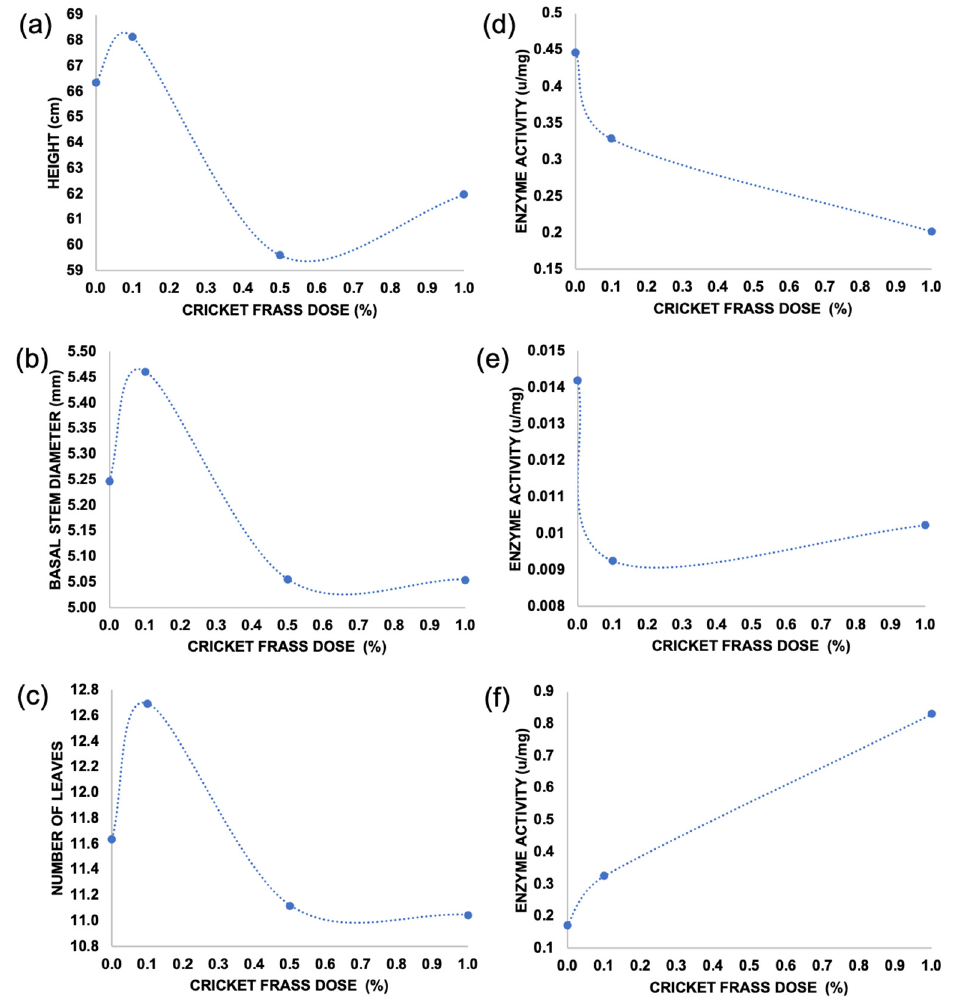
Figure 3. Dispersion diagram of morphological variables ( a ) height, ( b ) basal stem diameter, and ( c ) the number of leaves; and biochemical enzyme activities variables ( d ) PAL, ( e ) SOD and ( f ) CAT.